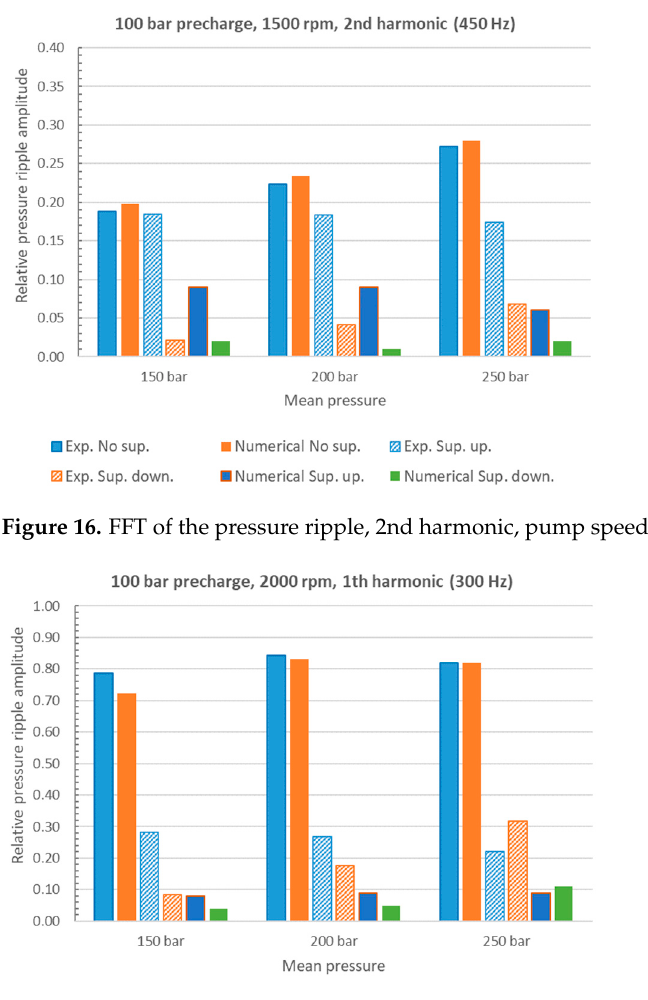
Figure 15. FFT of the pressure ripple, 1st harmonic, pump speed = 1500 rpm.